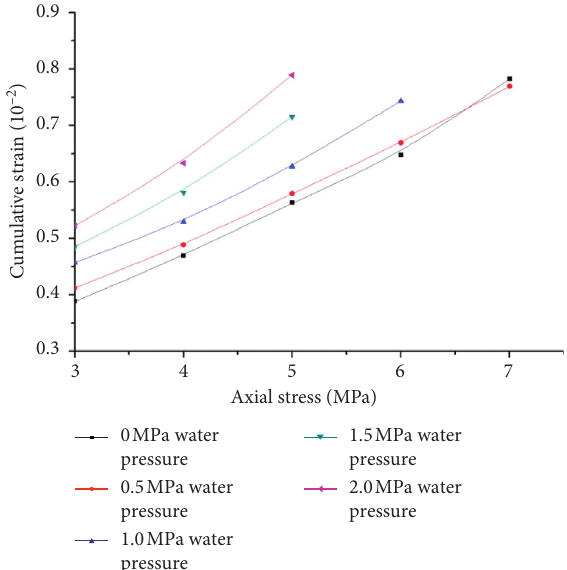
Figure 13: Cumulative strain–axial stress curve under different water pressures.